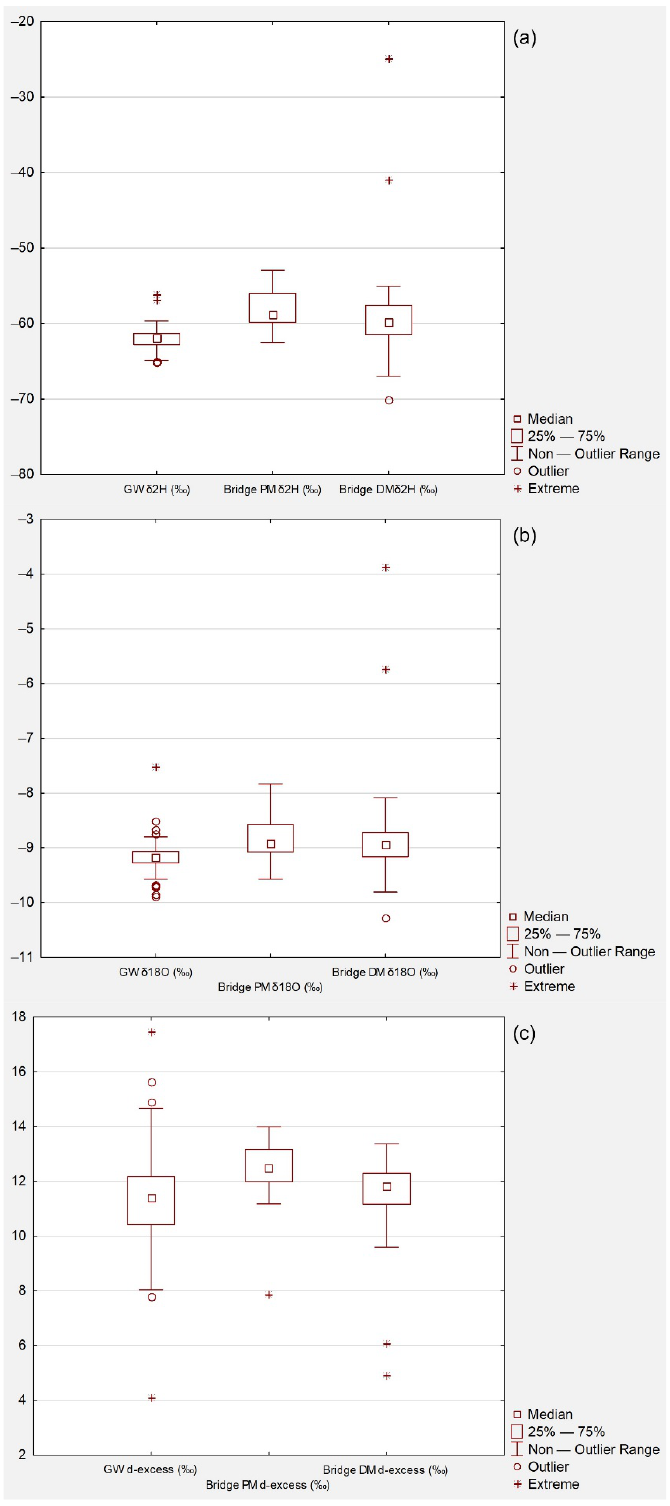
Figure 6. Boxplots of isotope composition of groundwater and the Sava River (PM and DM bridge) in the area of the Zagreb aquifer: ( a ) δ 2 H values; ( b ) δ 18 O values; ( c ) d -excess values. Periodic regression analysis was used to fit seasonal sine wave curves to annual δ 18 O variations. In Figure 7a ,b, amplitudes for the PM bridge are shown. Figure 7a presents an